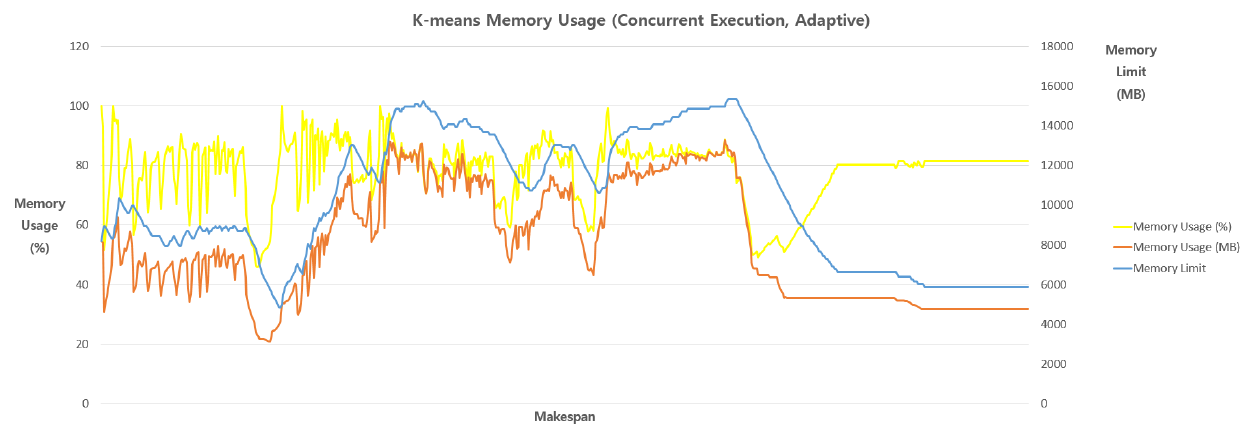
Figure 5. Memory usages in the K-means benchmark in the Adaptive approach to show an exemplary case of efficient resource usage